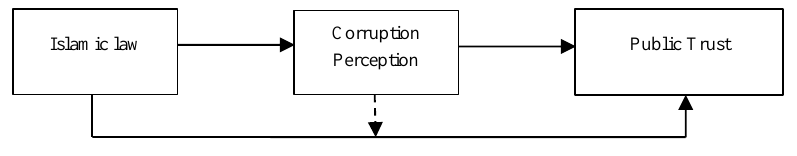
Figure 1: Framework